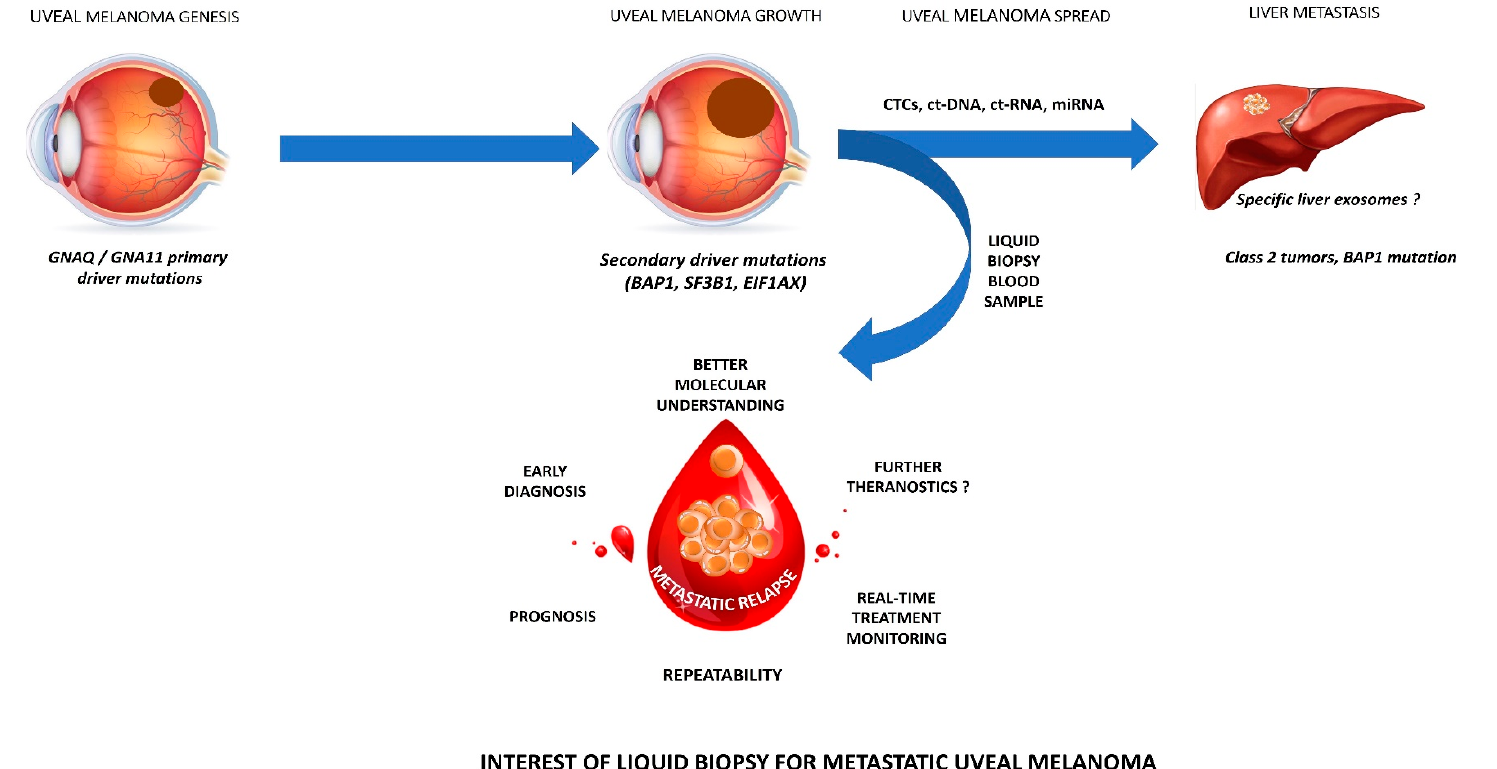
Figure 1. legend: Interest of liquid biopsy for metastatic uveal melanoma.